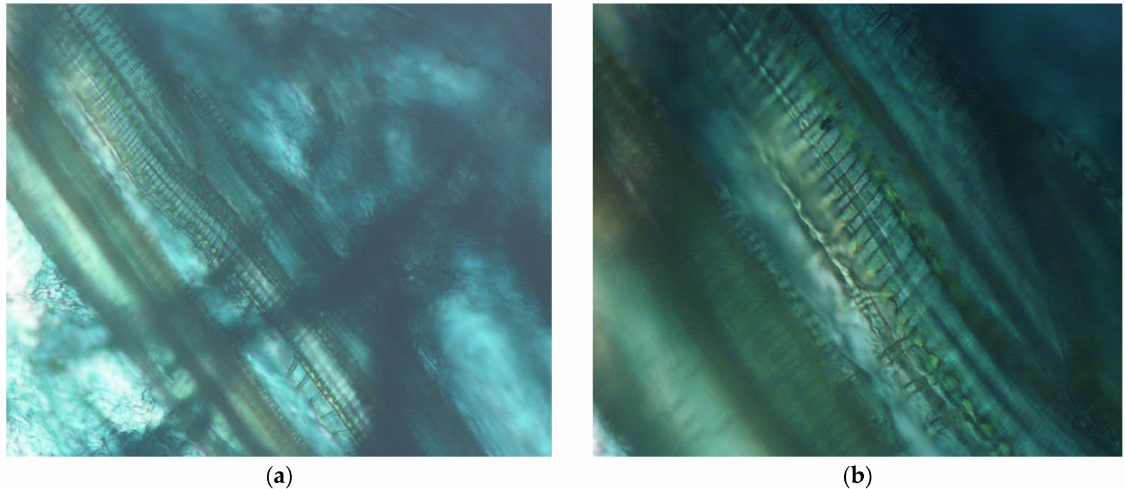
Figure 7. Optical microscopy images of sprout/PANI at low magnification ( a ) and high magnifica- tion ( b ).